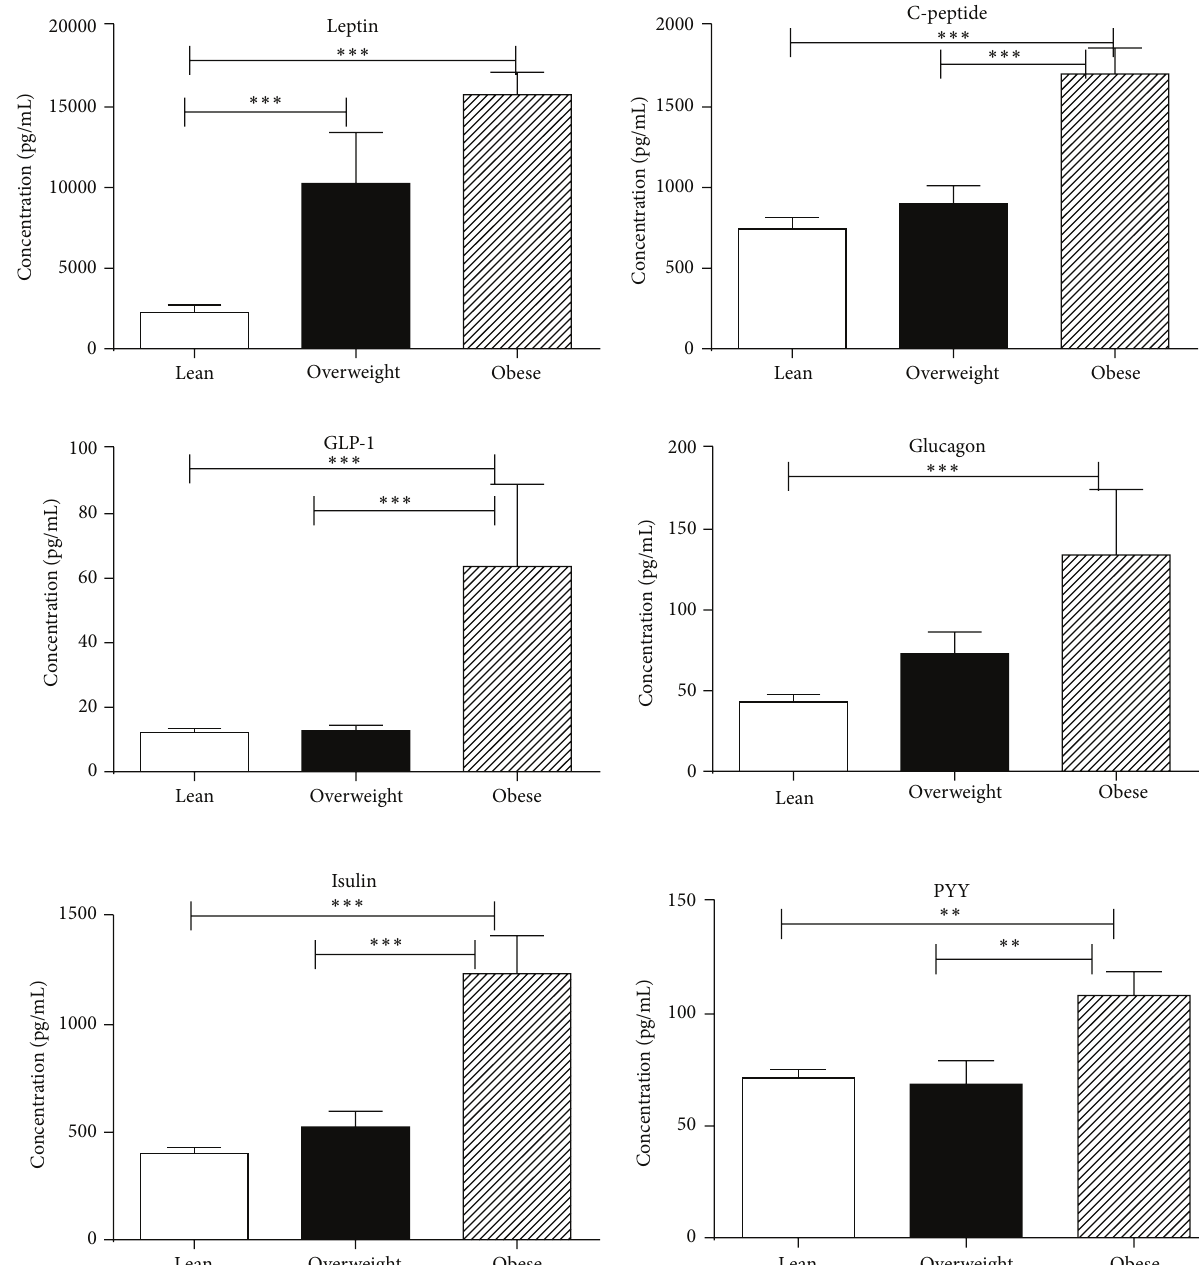
Figure 2: Metabolic hormones were determined multiplex cytokine bead array (CBA) in plasma of lean, overweight, and obese chimpanzee using Bio-Rad 200, Luminex technology. The results are expressed as pg/mL concentration. The results shown are an average of two distinct experiments. Comparison between groups of chimpanzees was done by one-way analysis of variance with the Kruskal-Wallis test as described in Figure